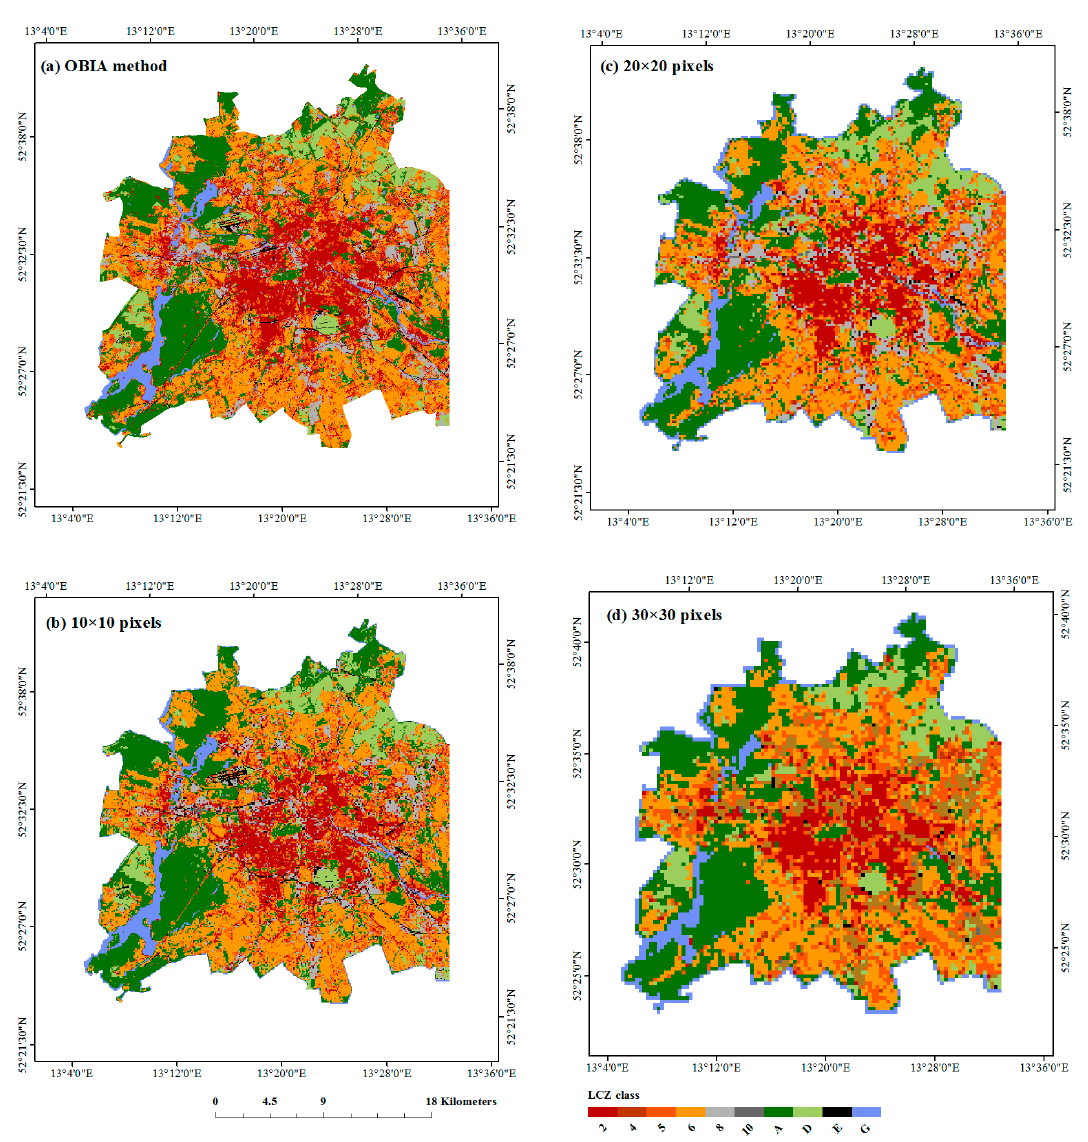
Figure 4. Mapping results for Berlin using the OBIA method and the pixel-based method. ( a ): the result based on OBIA; ( b ): the result based on 10 × 10 pixels; ( c ) the result based on 20 × 20 pixels; ( d ) the result based on 30 × 30 pixels. Table 3. OA results of two German